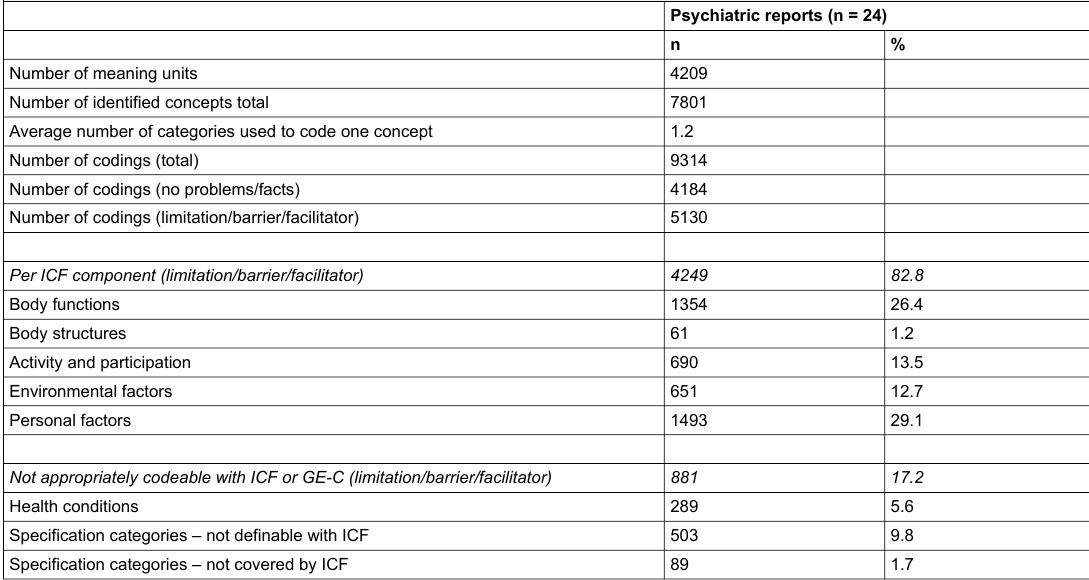
Table 3: Results of the coding process with the ICF and the personal factor categorisation by Geyh et al.